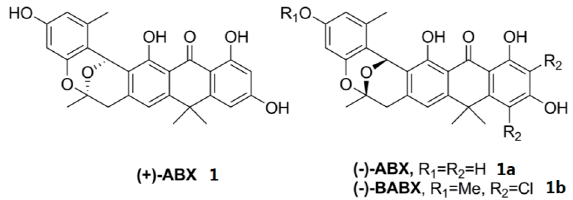
Figure 1. Chemical structure of ABXs.